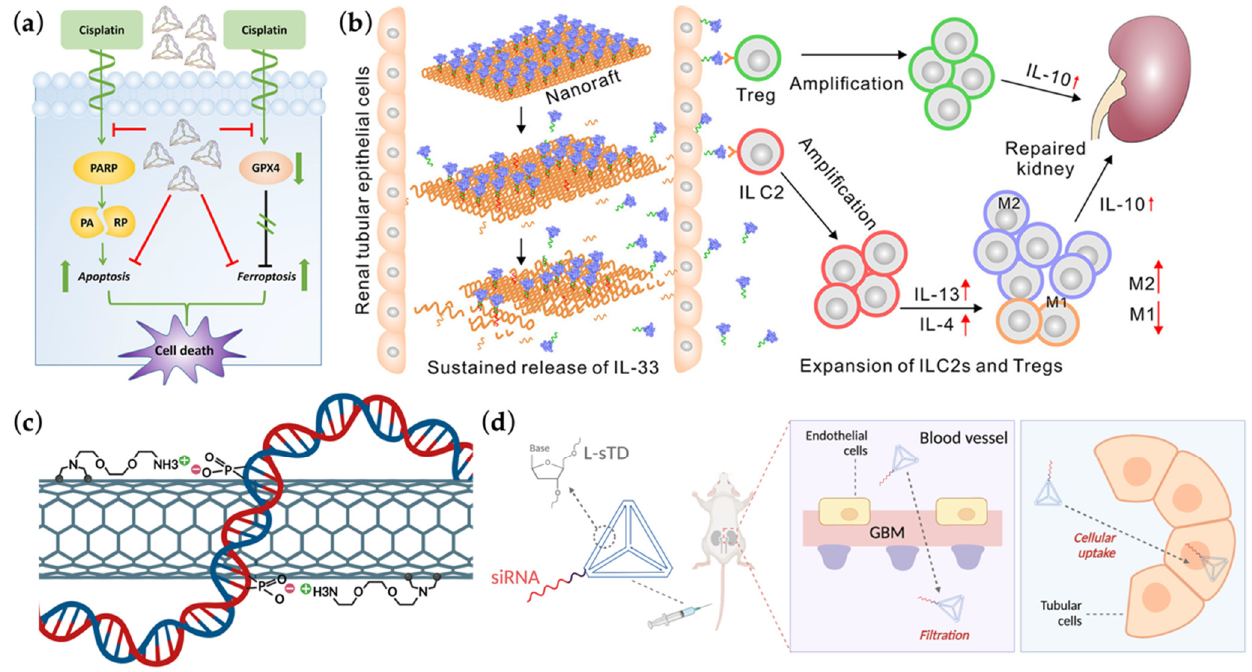
Figure 5. ( a ) Graphic display of the protective role DTNs play in cisplatin-induced AKI via inhibition of both ferroptosis and apoptosis. Adapted with permission from [108]. Copyright © 2022, American Chemical Society; ( b ) Sketch map of DON-based nanorafts rationally assembled with interleukin-33 and how the designed nanomachines function in immune-targeted AKI therapy. Adapted with permission from [110]. Copyright © 2022, American Chemical Society; ( c ) Schematic illustration of the conformation and noncovalent bonding between a fibrillar carbon nanotube and therapeutic short interference RNAs (siRNAs), realizing kidney-targeted delivery and AKI allevia- tion. Created with BioRender.com (19 January 2022); ( d ) Diagram of the incorporation of mirror DTNs and p53 siRNAs, in which DTNs contribute to renal distribution and tubular cell uptake while siRNAs are responsive for downregulating p53-related cellular apoptosis. Adapted with permission from [121] and created with Biorender.com (21 January 2022). Copyright © 2022, American Chemi- cal Society. 4. Conclusions and Outlook Herein, nucleic acid nanotechnology harnessed for diagnostics and therapeutics in AKI is mainly discussed, in which the specific binding ability, diverse range of targets and easy incorporation into various biochemical platforms contribute to novel methods for AKI early recognition while the flexible designability, clear addressability, low immuno-